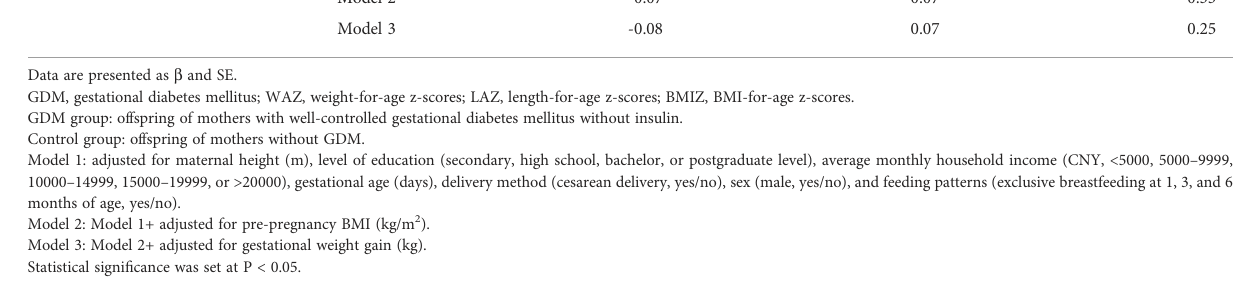
Data are presented as b and SE. GDM, gestational diabetes mellitus; WAZ, weight-for-age z-scores; LAZ, length-for-age z-scores; BMIZ, BMI-for-age z-scores. GDM group: offspring of mothers with well-controlled gestational diabetes mellitus without insulin. Control group: offspring of mothers without GDM. Model 1: adjusted for maternal height (m), level of education (secondary, high school, bachelor, or postgraduate level), average monthly household income (CNY, <5000, 5000 – 9999, 10000 – 14999, 15000 – 19999, or >20000), gestational age (days), delivery method (cesarean delivery, yes/no), sex (male, yes/no), and feeding patterns (exclusive breastfeeding at 1, 3, and 6 months of age, yes/no). Model 2: Model 1+ adjusted for pre-pregnancy BMI (kg/m 2 ).